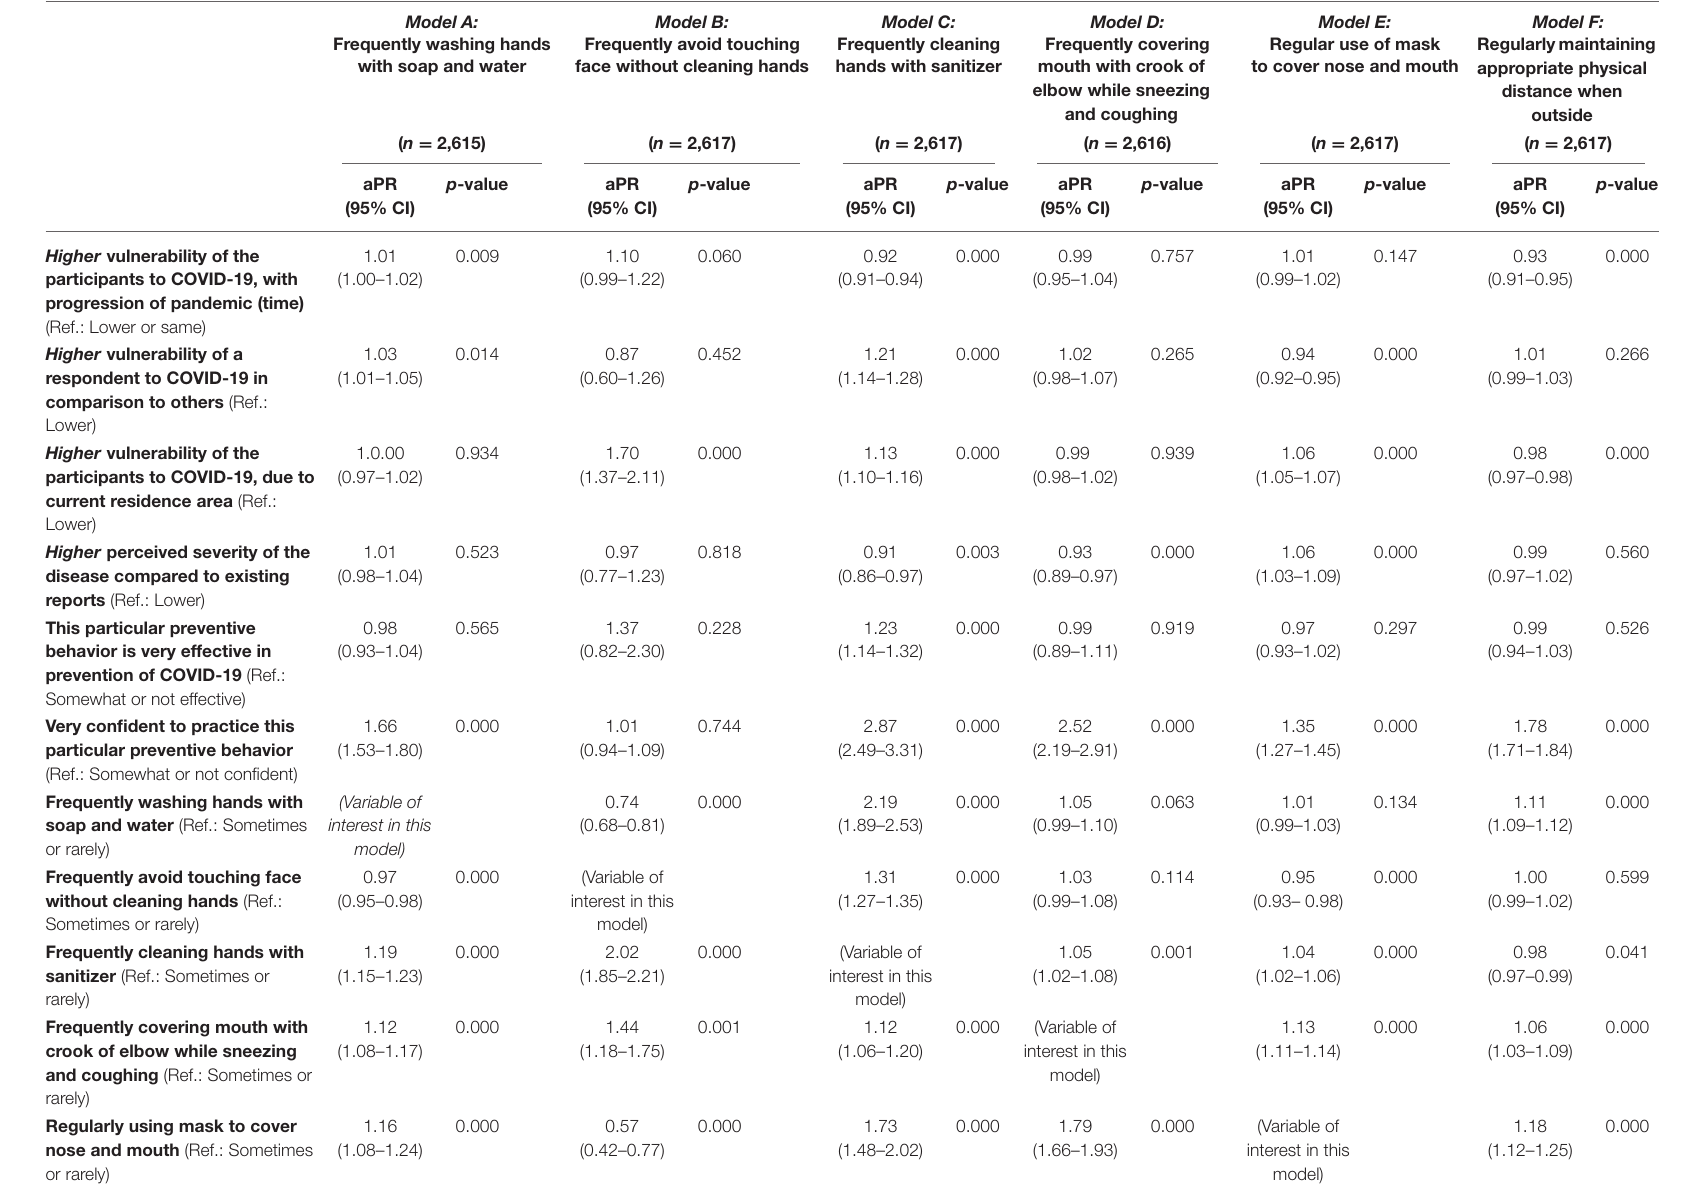
TABLE 6 | Prevalence ratios (95% CI) of the predictors of self-reported practices of selected COVID-appropriate preventive